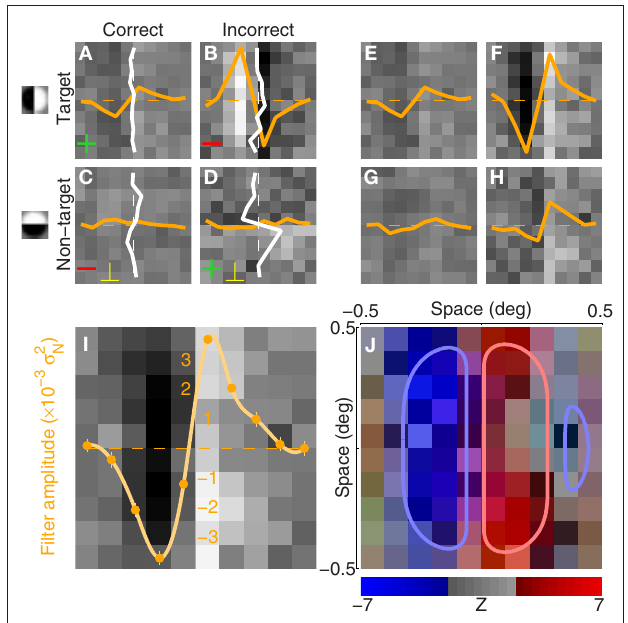
Figure 2 | Procedure for deriving the perceptual filter from classified noise. Data from aggregate observer ( > 180 K trials). (A–D) Show average noise images from target (A,B) or non-target (C,D) probes on correct (A,C) or incorrect trials (B,D) . Yellow traces show marginal averages taken vertically across the image, white traces horizontally. Before combining all four images into 1, some were summed [green + signs in (A,D) ] and others were subtracted [red − signs in (B,C) ] as well as transposed [yellow ⊥ symbol in (C,D) ], to obtain the four images shown in (e–H) (see Section 2). The combined image is plotted in I (yellow trace shows marginal average in units of external noise variance σ N2 ), and a Z score map of this image is shown in (J) [colored pixels refer to | Z | > 2]. The smooth outlines in (J) show contour lines at 1/3 (light red) and − 1/3 (light blue) of peak value for the pseudo-Gabor fit (see